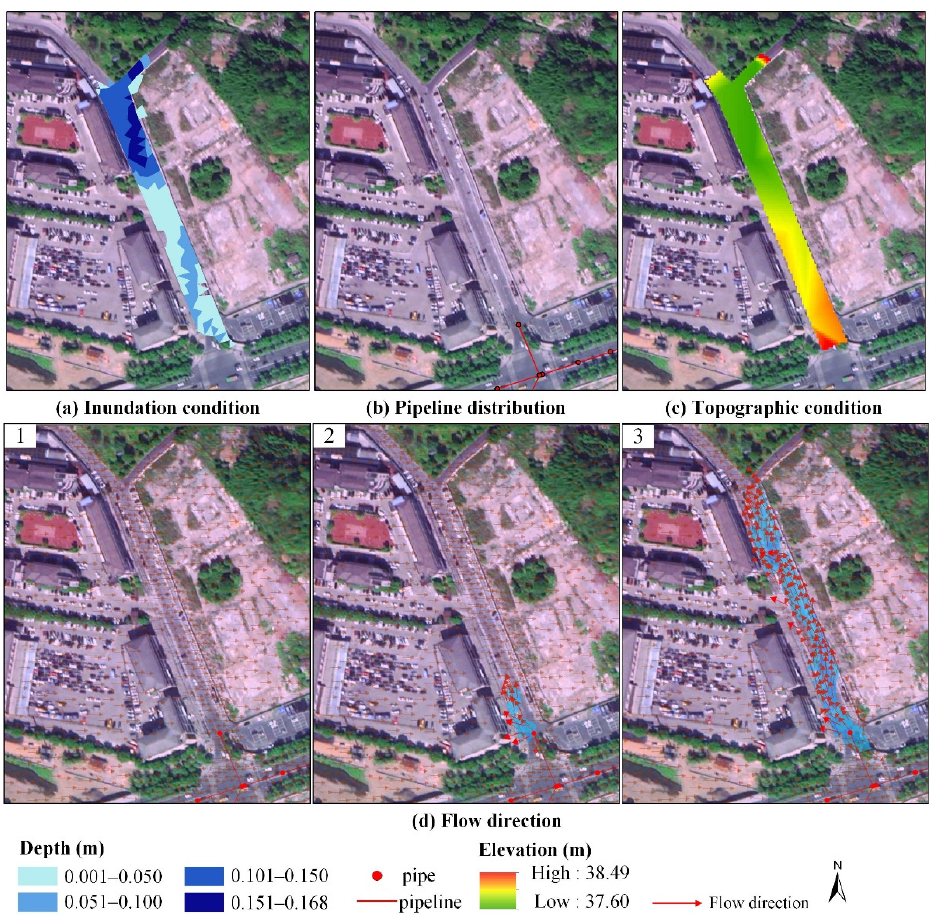
Figure 9. The inundation situation in MXR (the image came from aerial photography).